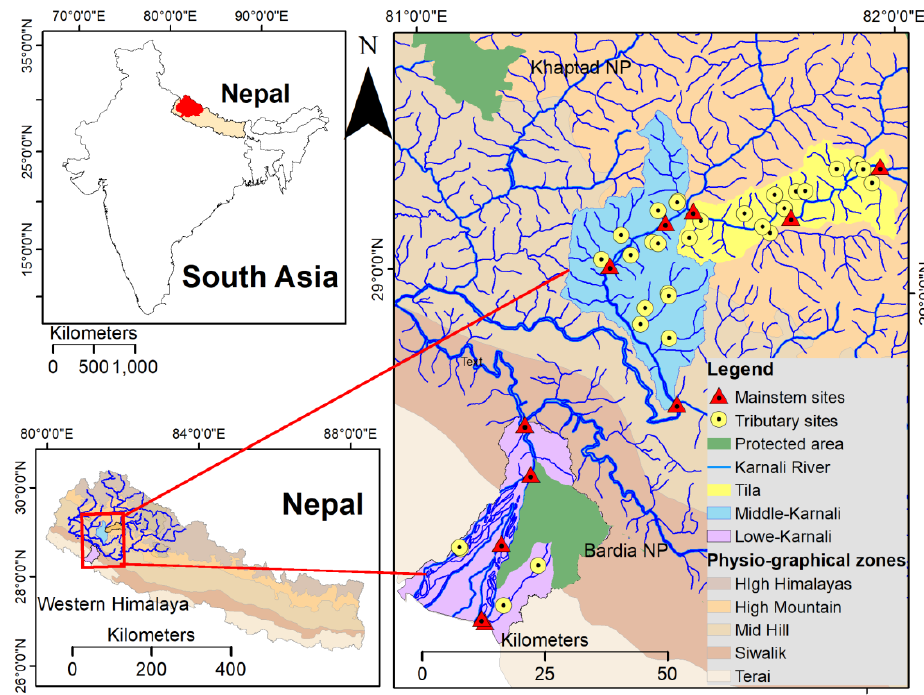
Figure 1. Study area, located in the western Himalaya, Nepal, south Asia (top left image). The area’s physiographical zones (bottom left image); the two major national parks (Khaptad NP and Bardia NP) and the sampling sites across the Karnali River’s tributaries and mainstem are also depicted (right image). NP stands for National Park.